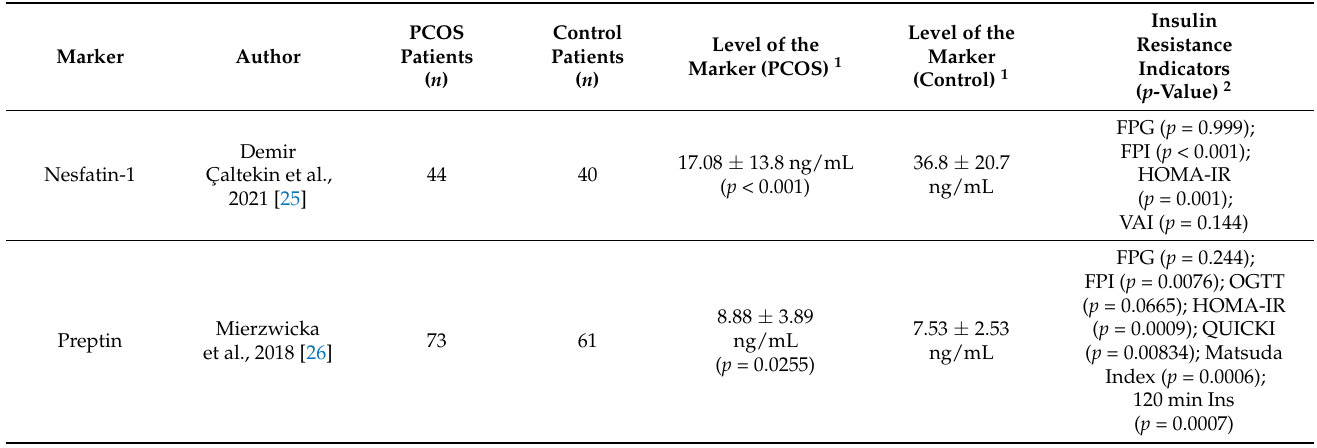
Table 1. Recent studies comparing serum fasting levels of each of the markers between patients with PCOS and healthy